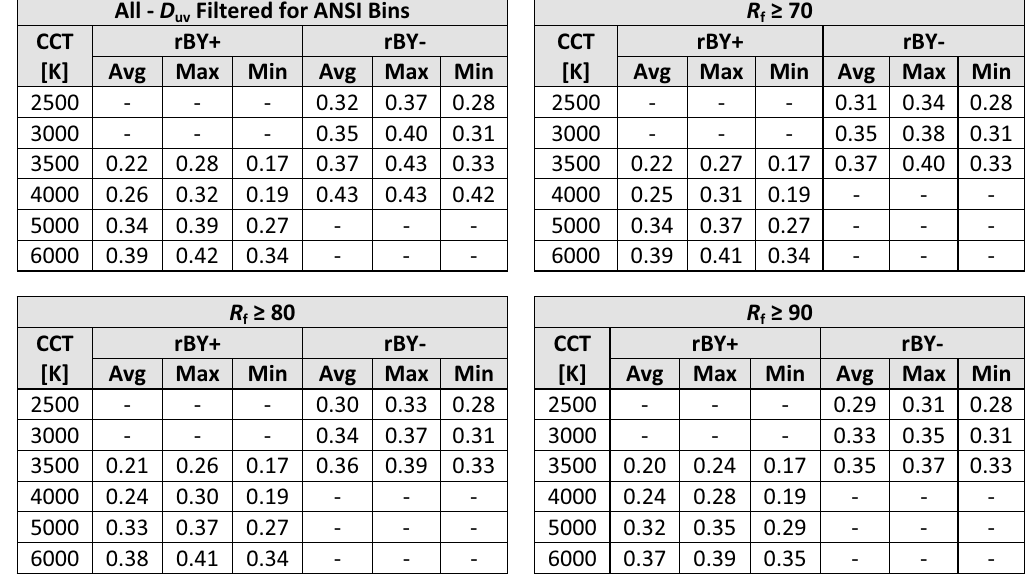
Table 3. A summary of circadian stimulus as a function of CCT with various R f filtering. rBY+ indicates "blue wins". rBY- indicates "yellow wins" and is determined by the balance of spectral content relative to 500 nm, approximately.